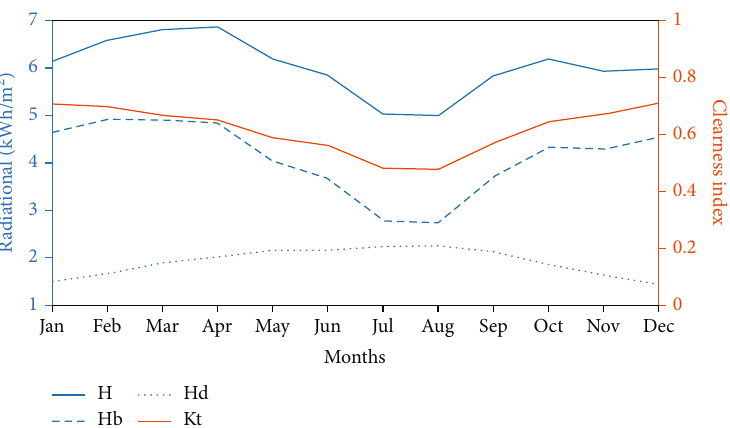
Figure 3: Global horizontal radiation (H), beam radiation (Hb), di ff use radiation (Hd), and clearness index (Kt) of Bahir Dar city.